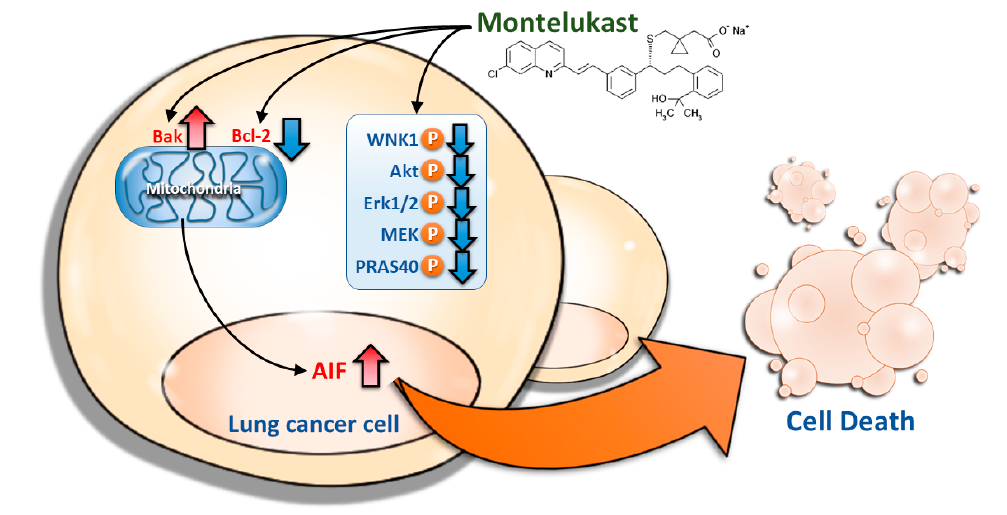
Figure 7. Illustration of the mechanism through which montelukast induced the cell death of lung cancer cells. Montelukast decreased the phosphorylation of several proteins, such as WNK1, Akt, Erk1/2, MEK, and PRAS40, down-regulated Bcl-2, up-regulated Bak, and induced the nuclear translocation of AIF, contributing to the cell death of lung cancer cells. (Red upward arrows: up-regulation; blue downward arrows: down-regulation)